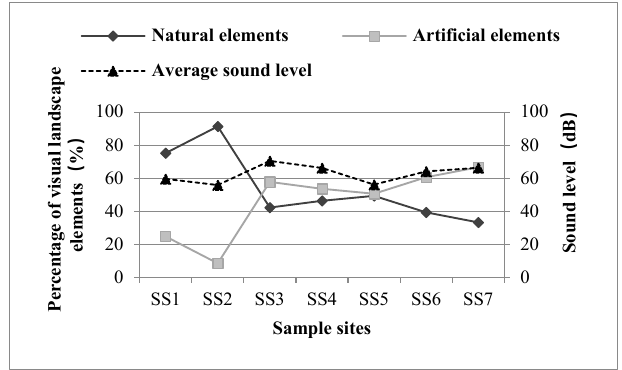
Figure 2. Visual landscape element composition and sound level of the park.